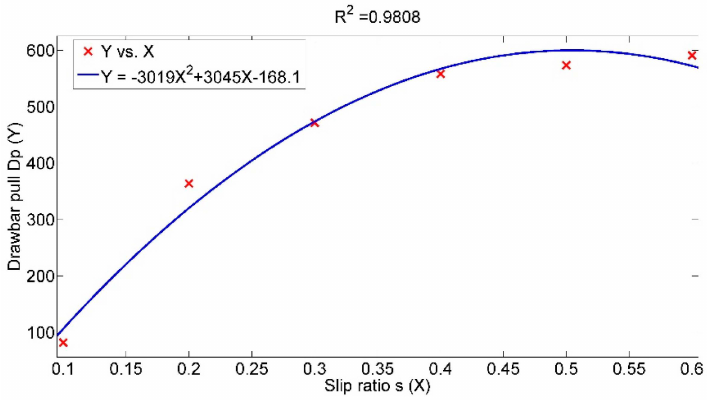
Figure 8. Drawbar pull with respect to slip